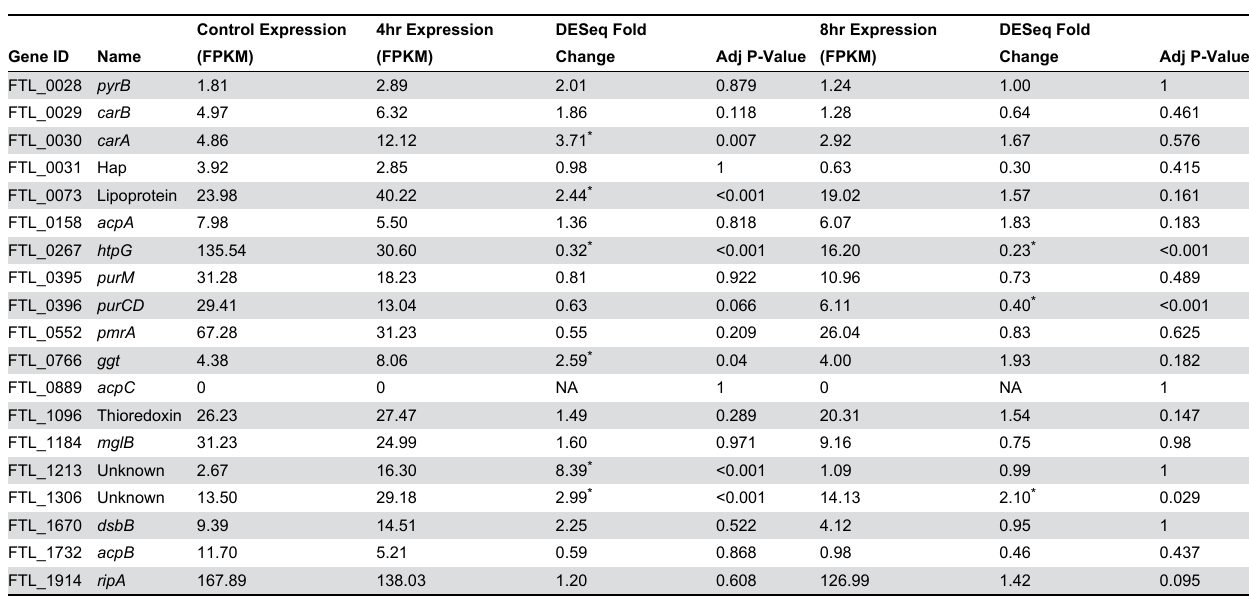
Table 4. Expression of non-FPI genes encoding virulence